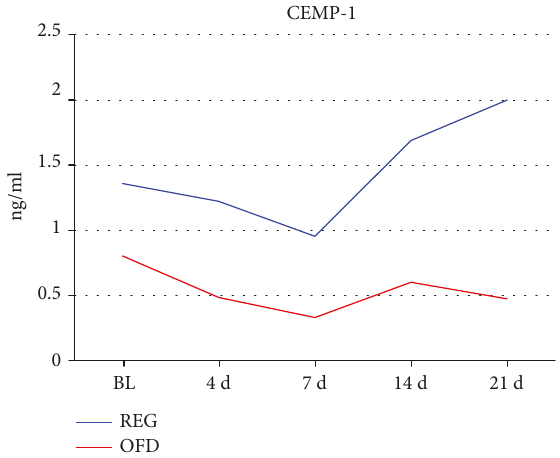
Figure 4: LevelsofCEMP-1ingingivalcrevicular fl uid(atbaseline,0) and periodontal wound fl uid at 4, 7, 14, and 21 days (d), postop in sites treated with regenerative approach (REG) and open fl ap debridement (OFD).